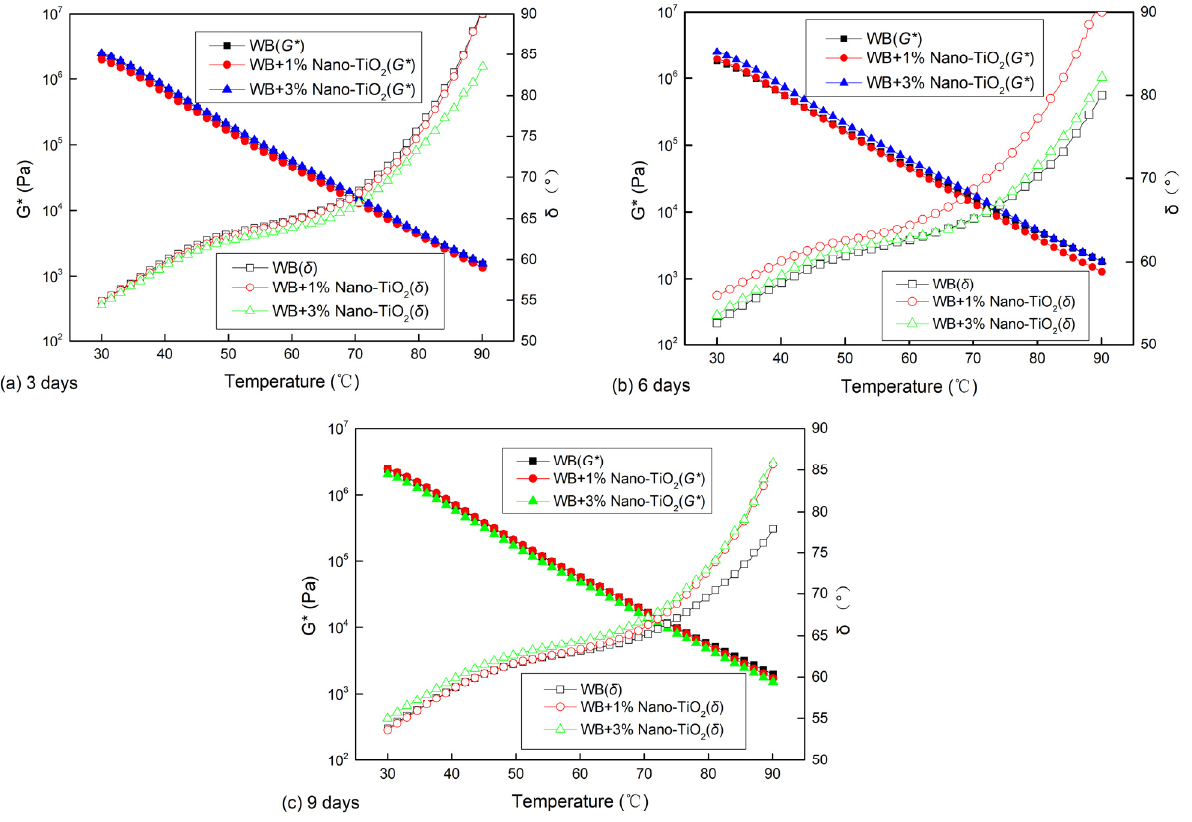
Figure 3. Complex moduli and phase angles of UV-aged binders increased with the tested temperature: ( a ) UV aging for 3 days; ( b ) UV aging for 6 days [20] ; ( c ) UV aging for 9 days.